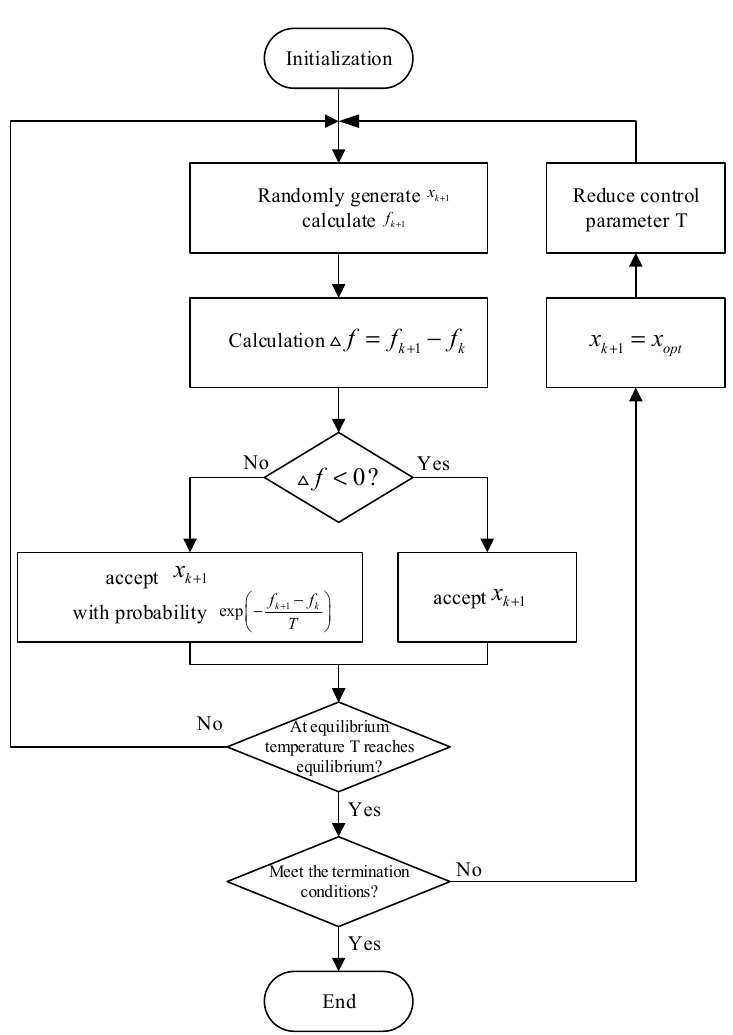
Figure 2. Flow chart of optimization algorithm for auxiliary anode system based on simulated annealing.